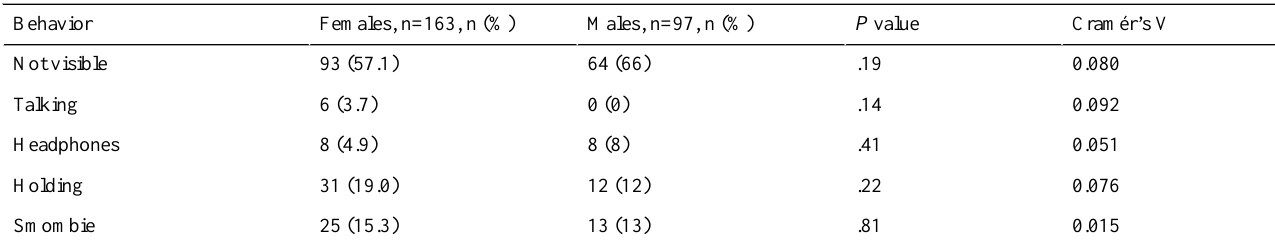
Table 5. Influence of gender on smartphone usage behavior in teenagers (n=260, globally P =.12, V=0.17).